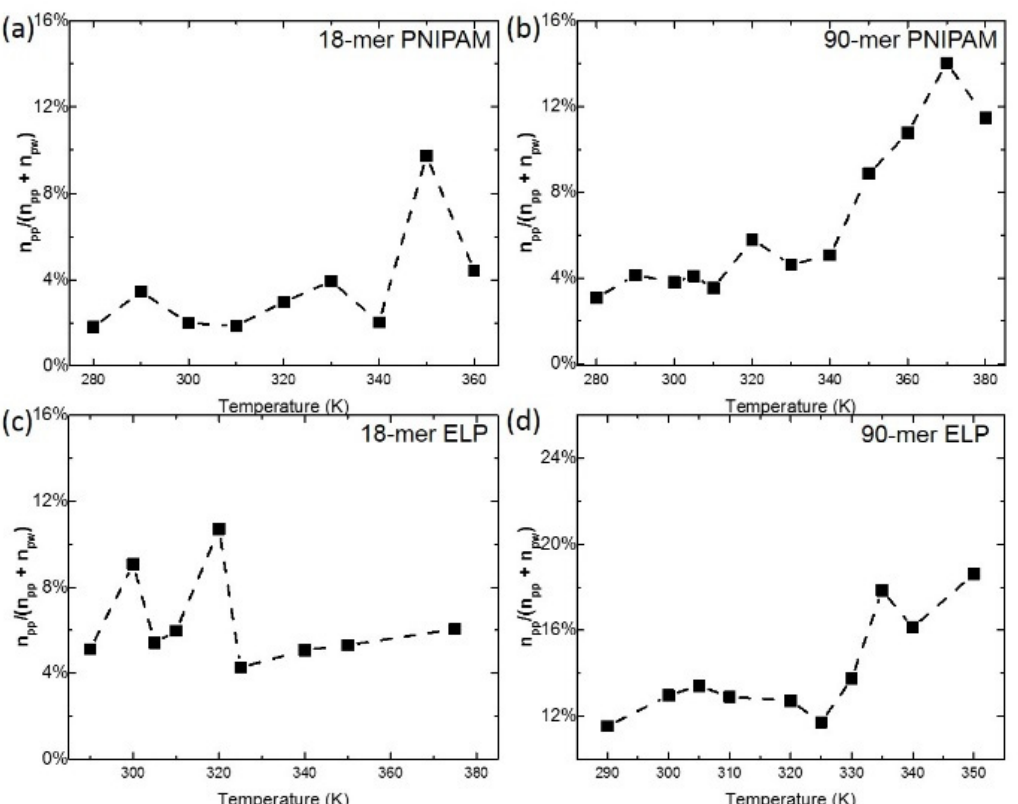
Figure 4. Dehydration ratio, defined as ratio between number of polymer-polymer hydrogen bonds (n pp ) and total hydrogen bonds (n pw + n pp ). ( a , b ) show the dehydration ratio of 18-mer and 90-mer of PNIPAM, respectively. ( c , d ) show the dehydration ratio of 18-mer (GVG(VPGVG) 3 ) and 90-mer ((VPGVG) 18 ) of ELP, respectively.